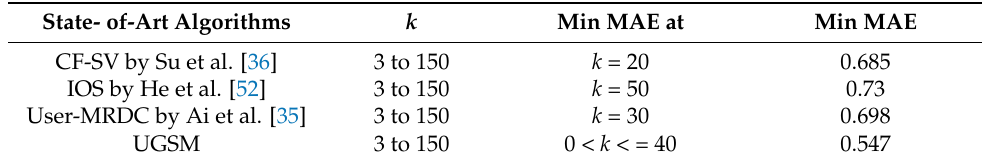
Figure 6. Comparison of UGSM and traditional similarity measures according to (1) MAE; (2) P L; and (3) Rel L; for ( a ) ML-20M dataset and ( b ) R2-Yahoo Music dataset. Table 10. Comparison of UGSM’s MAE to state-of-the-art algorithms. State- of-Art